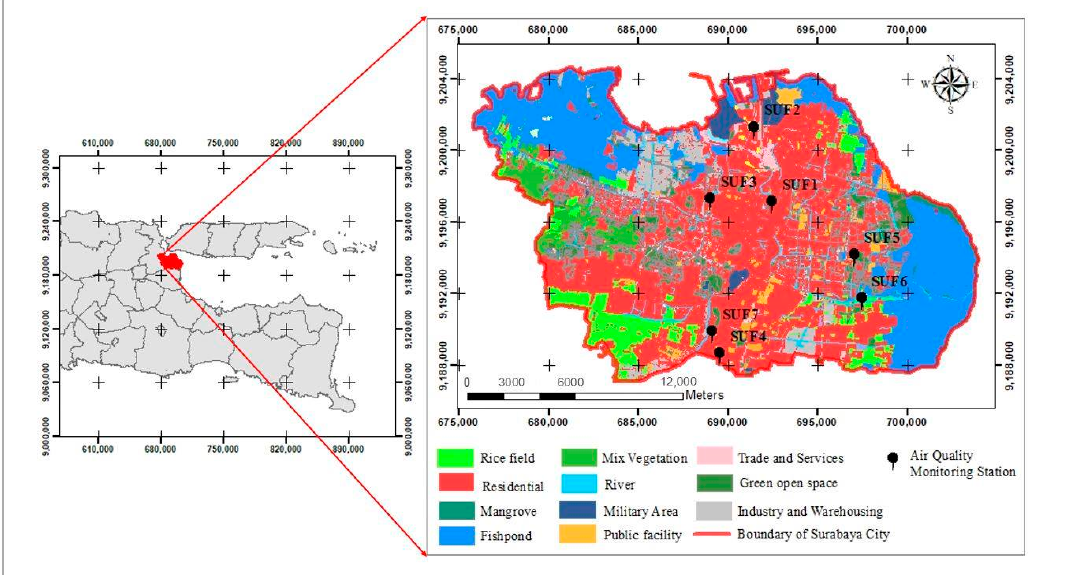
Figure 1. Location of Surabaya City and its land-use allocations.